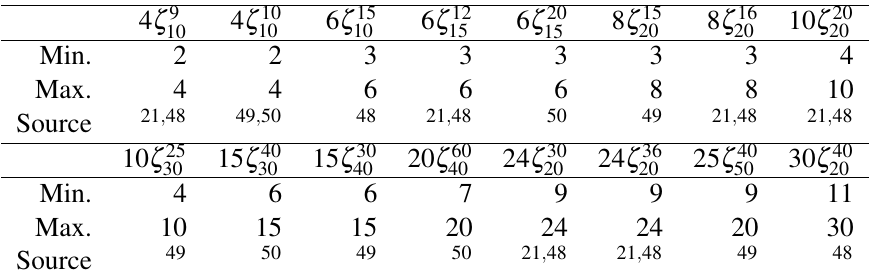
Table 1: Problem Instances considered in the experimental evaluation. The minimum and maximum of tools required for all the jobs is indicated, as well as the work(s) from which the problem instance was obtained (see , where C is the magazine capacity, m is the total bibliography section). Recall we are using the notation C ζ m n number of tools and n is the number of